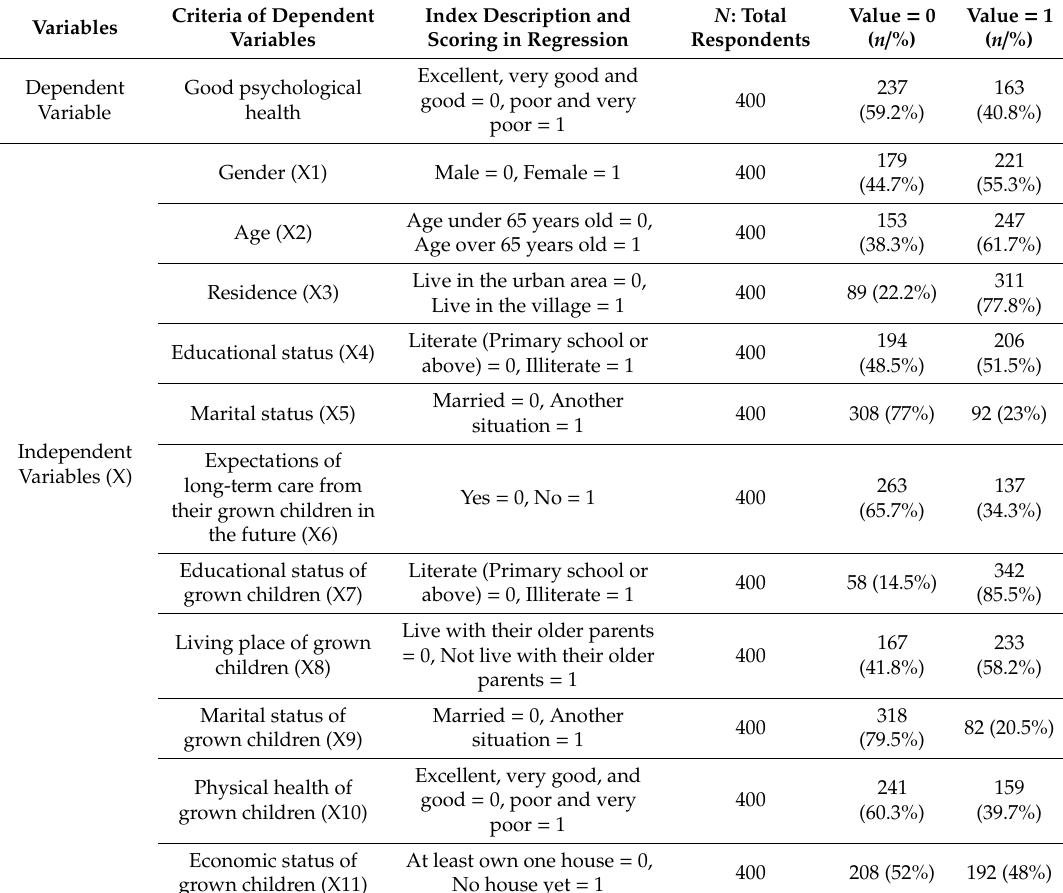
Table 1. Description of